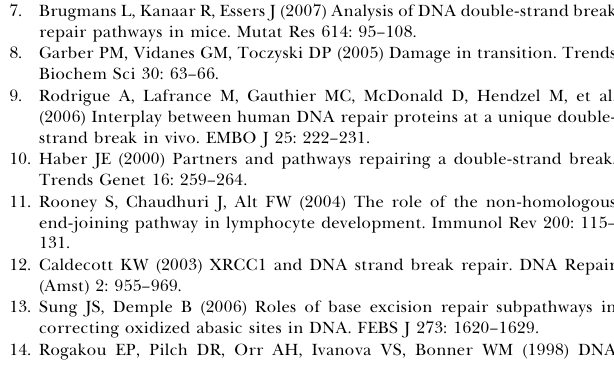
Figure S1. Sequence Alignment of Mutated DT40 PolyLacO- k R GFP- LacI and DT40 PolyLacO- k R LacI-HP1 Clones Sequences of unique, mutated V k regions from diversified (A) DT40 PolyLacO- k R GFP-LacI and (B) DT40 PolyLacO- k R LacI-HP1 cells. Clear blue boxes outline gene conversion tracts; red circles denote point mutations; black dotted boxes indicate nontemplated inser- tions; orange triangles denote deletions; blue-shaded boxes indicate ambiguous changes. Found at doi:10.1371/journal.pbio.0050246.sg001 (83 KB